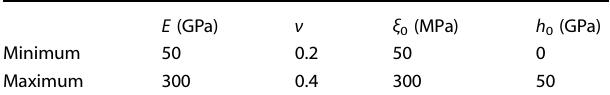
Table 3. Material property ranges used for generating the